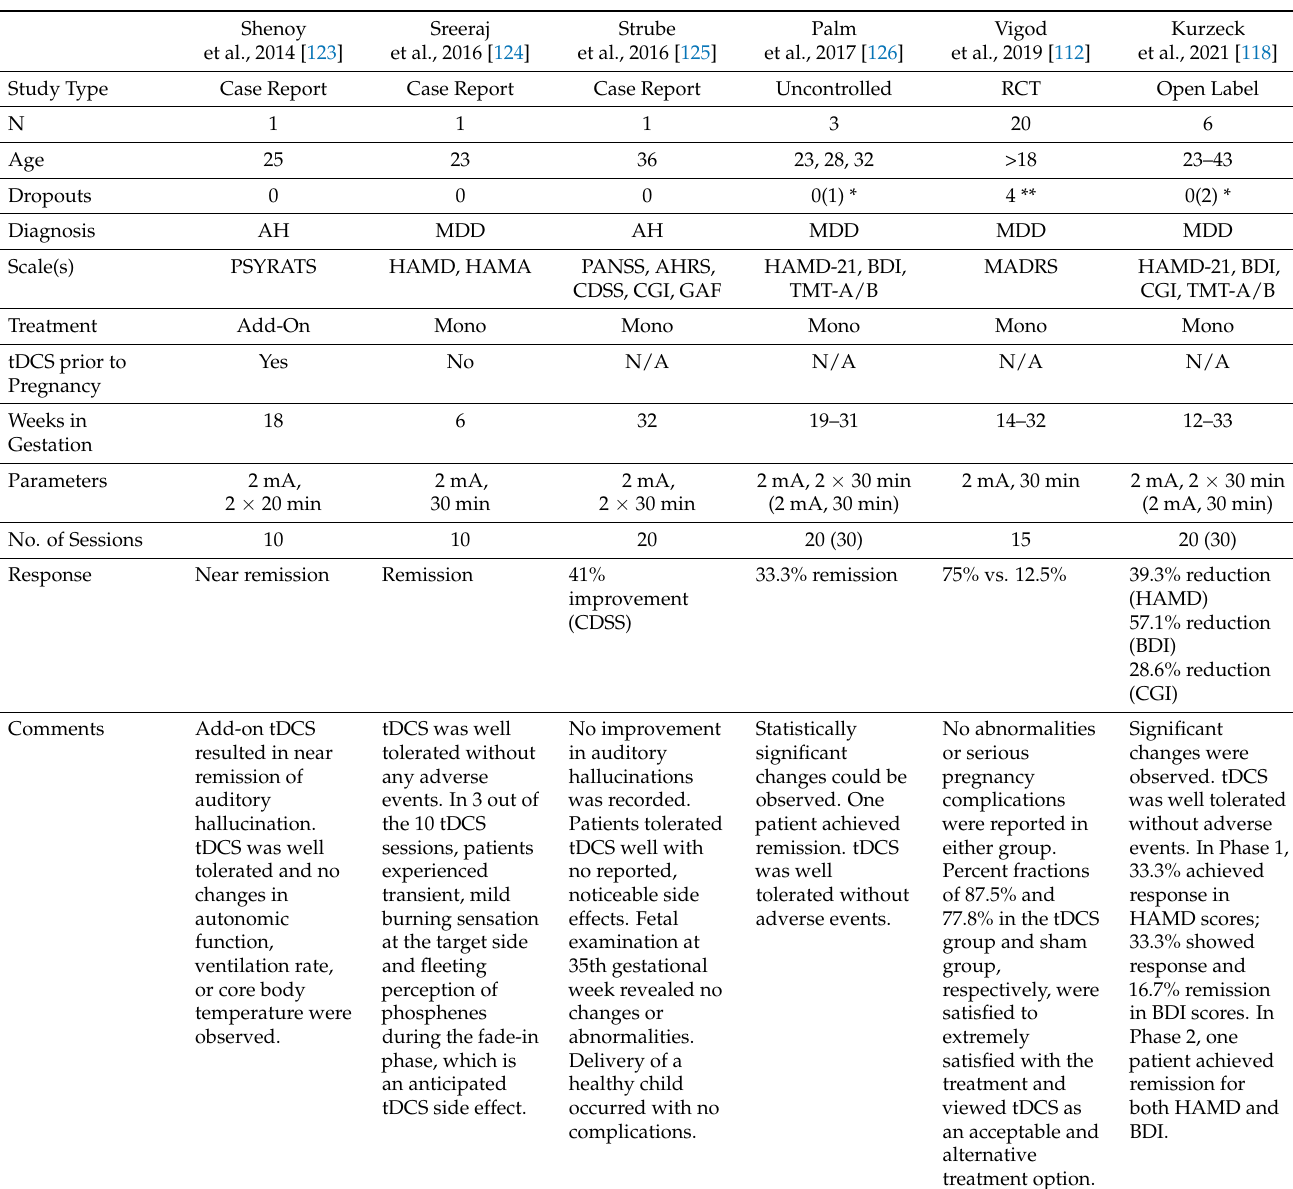
Table 2. Studies reporting on efficacy and safety of transcranial direct current stimulation (tDCS) in